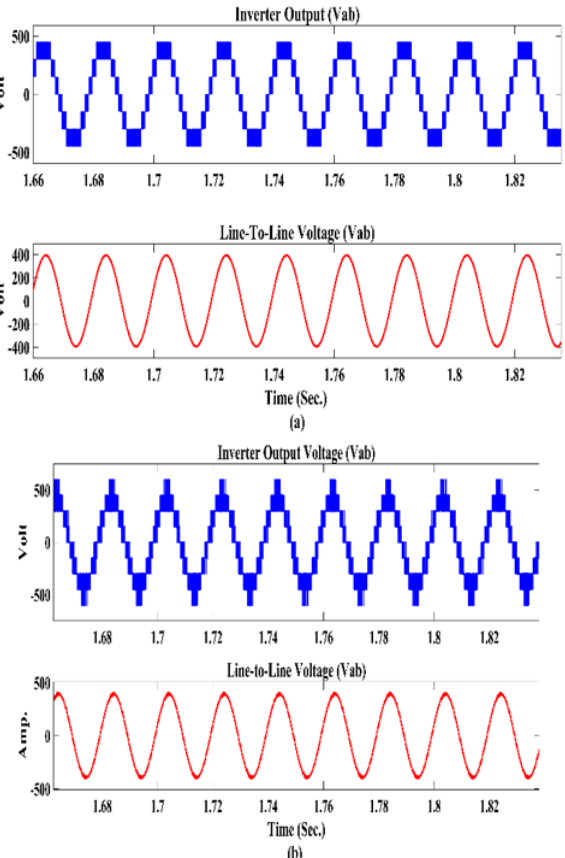
Fig. 6. Line-to-Line output voltage with: (a) PD-PWM, (b)